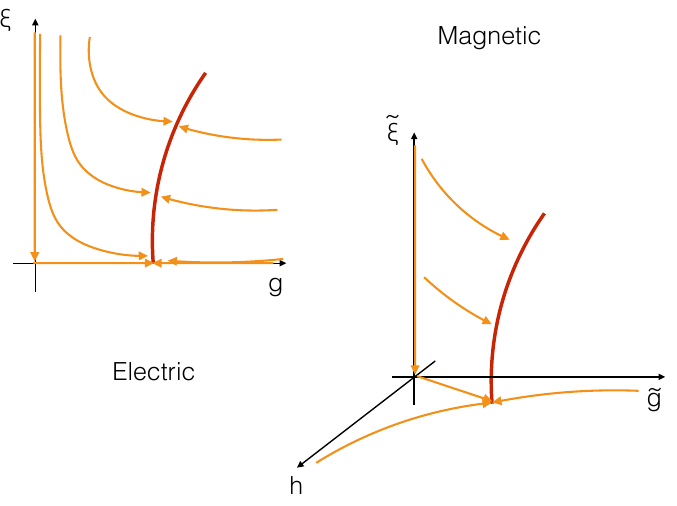
Figure 1 . On the l.h.s.: couplings of the electric SQCD for N f = 2 N c SQCD deformed by a quartic superpotential for the quarks. On the r.h.s. couplings of the dual magnetic SQCD for N f = 2 N c SQCD deformed by a quadratic superpotential for the meson. The red lines represent the dual marginal deformations on both sides of the duality after the addition of the respective